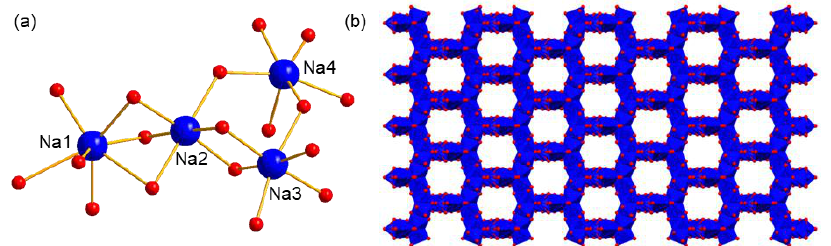
Figure 3. ( a ) The coordination environments of four independent Na + , and ( b ) the packing model of counter cation Na + in compound 1 . The polyanions are omitted for clarity. Blue ball: Na, red ball O, blue polyhedron: {NaO 6 } or {NaO 7 }.